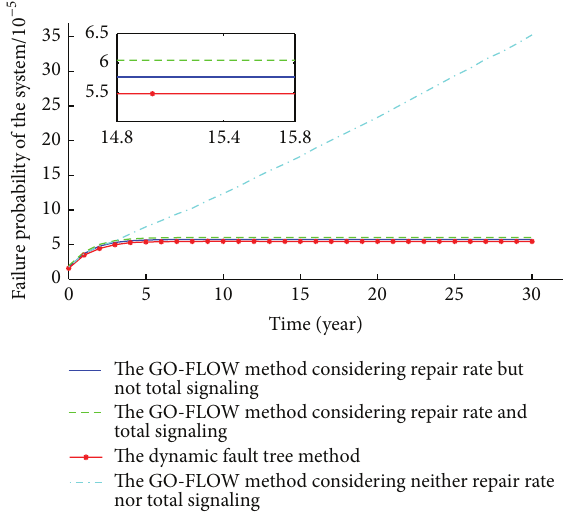
Figure 8: The failure probability’s changing trend of NPP’s offsite power system.